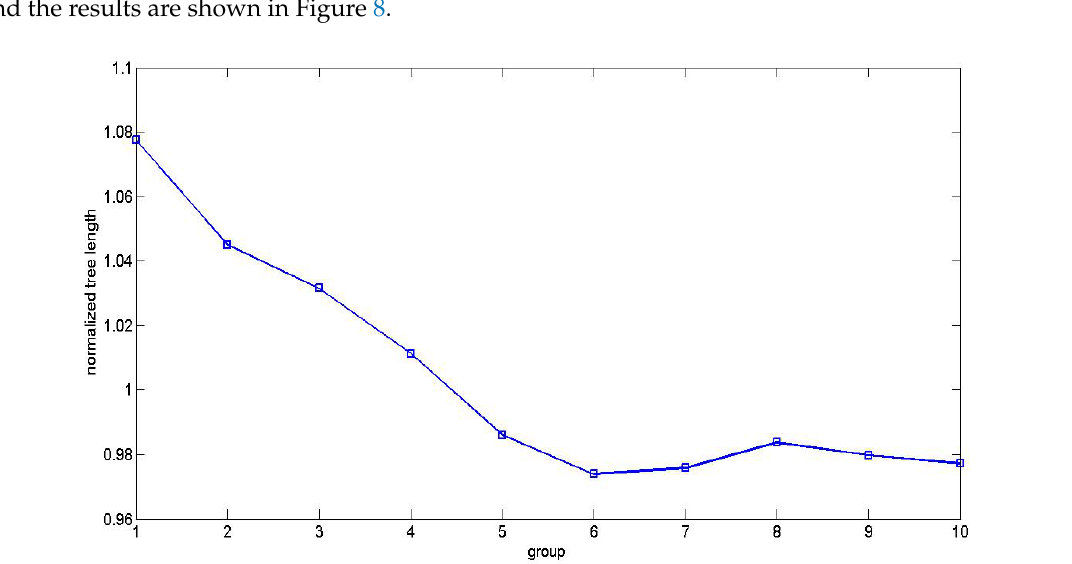
Figure 8. The mean value of the normalized tree length in each group according to the average return volatility of the FX market index with the corresponding time